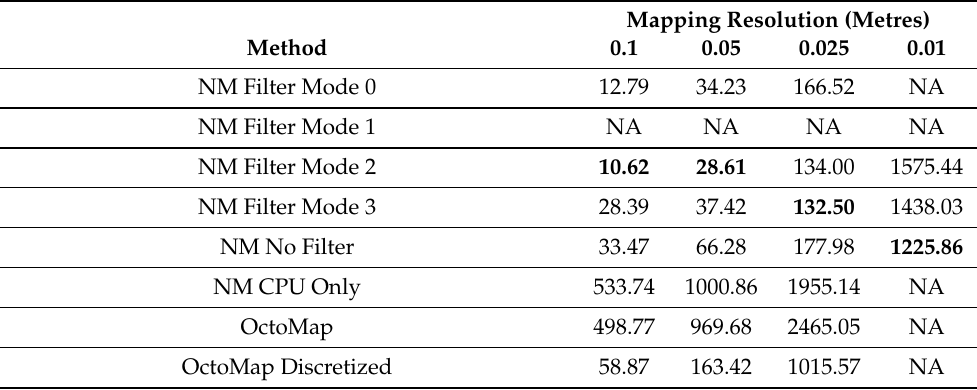
Table 5. Freiburg dataset average frame time for Jetson Nano (ms, lower is